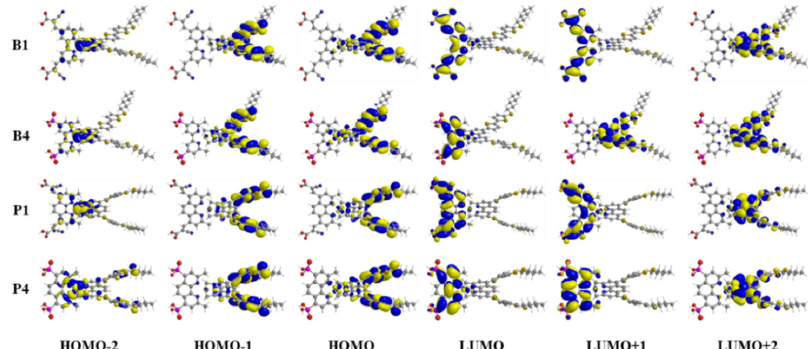
+ 2 of B1, B4, P1, and